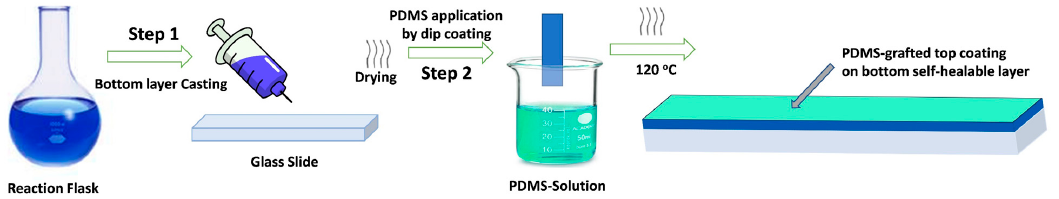
Figure 2. Illustration of the dual-layered approach for preparing a PU coating possessing both self-healing and self-cleaning properties.